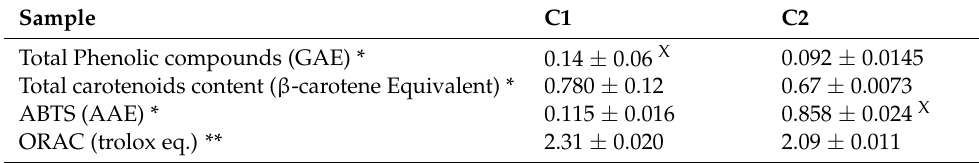
Table 3. Antioxidant capacity and total phenolic